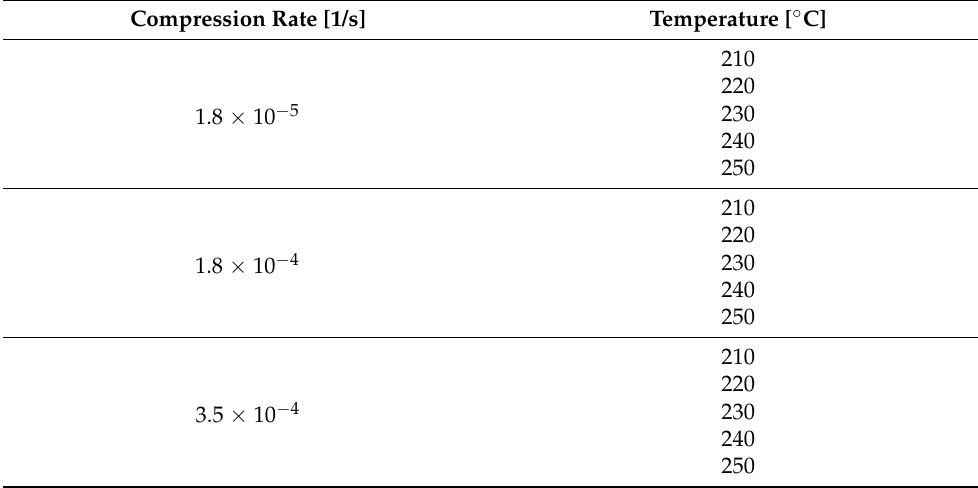
Table 1. Experiments to determine the dynamic pressure-induced solidification of the COC.